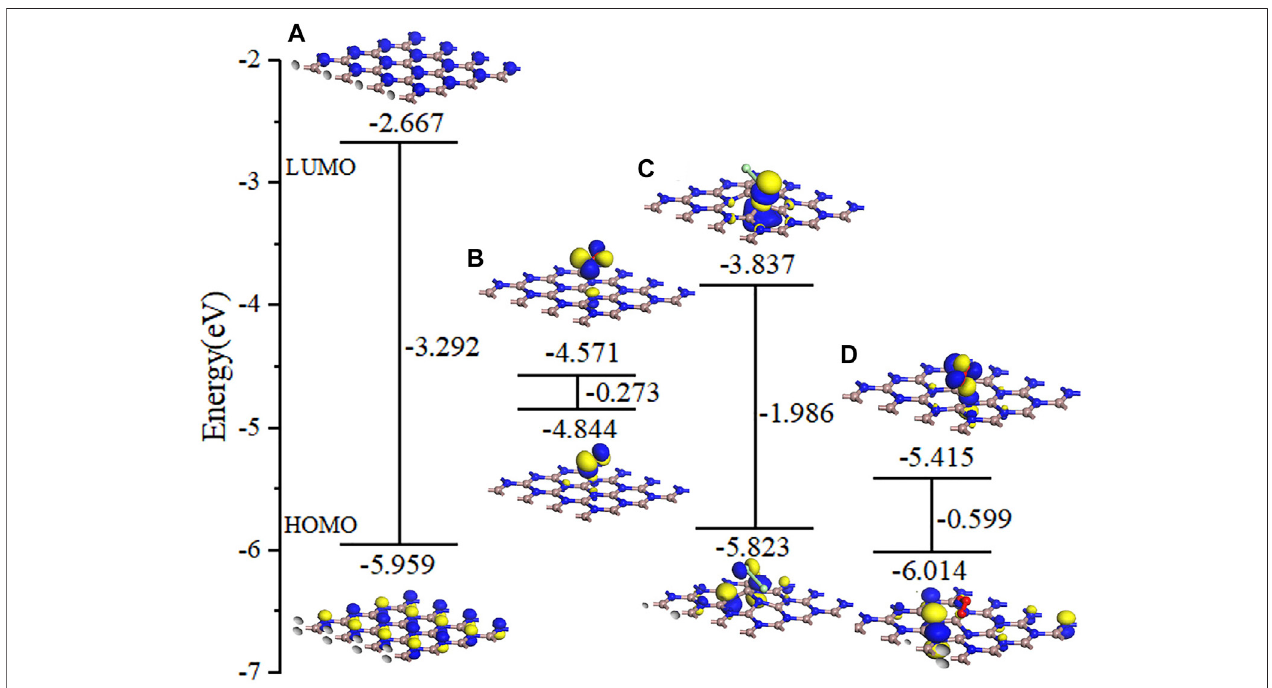
FIGURE 9 | Molecular orbital for (A) GaN monolayer, (B) NO, (C) Cl 2 , and (D) O 3 on the GaN surface.